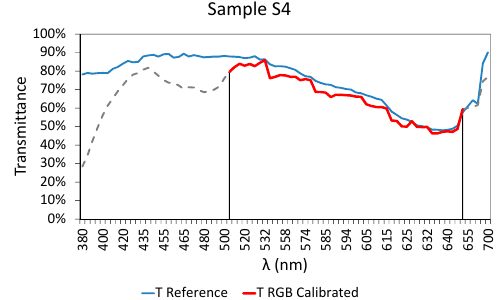
Figure 18. RGB-LED calibration between 380 and 700 nm for sample S4.